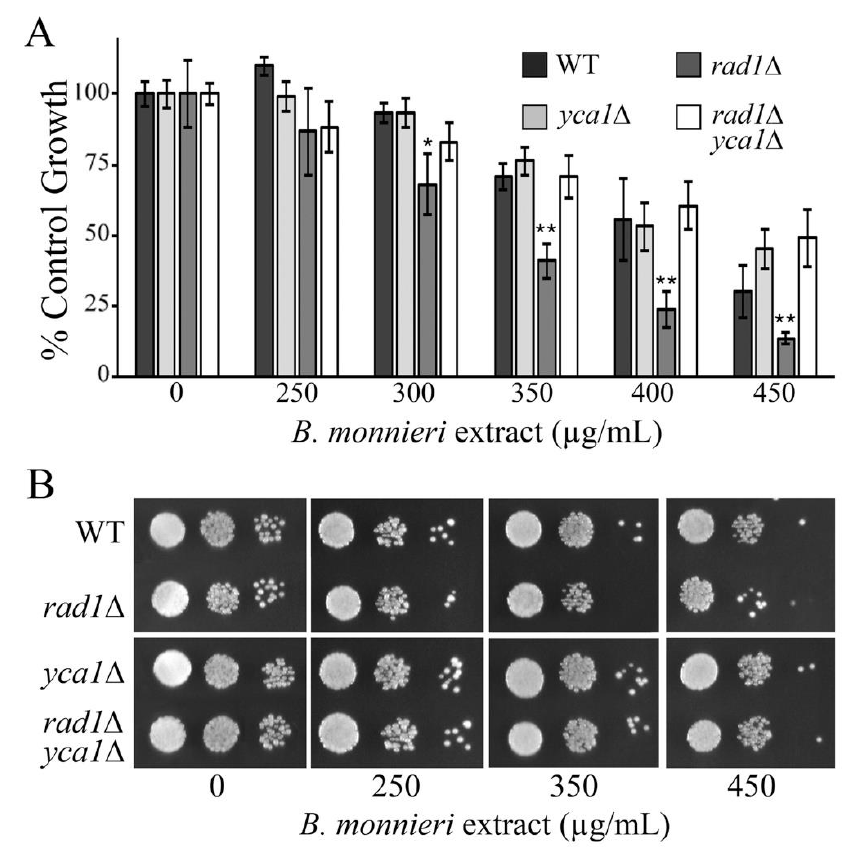
Figure 8. The meta-caspase Yca1p is required in rad1 ∆ cells to promote toxicity from B. monnieri extracts. ( A , B ) Yeast strains WT, rad1 ∆ (12806), yca1 ∆ (LJ464), and rad1 ∆ yca1 ∆ (LJ465) were grown in synthetic medium with 2% glucose in the presence of 2% DMSO and 0.2% Tween 80 (vehicle control) or B. monnieri extracts at the concentrations listed. Values are mean ± SD ( n = 3). Growth was monitored by measuring OD at 600 nm with vehicle control (0) set at 100%. Statistical analysis employed Student’s t-test with ** p < 0.01, * p < 0.05. ( B ) Serial dilutions of liquid cultures from were spotted onto solid synthetic medium with 2% glucose as described in Figure 3. Samples were incubated for 3 days and photographed.